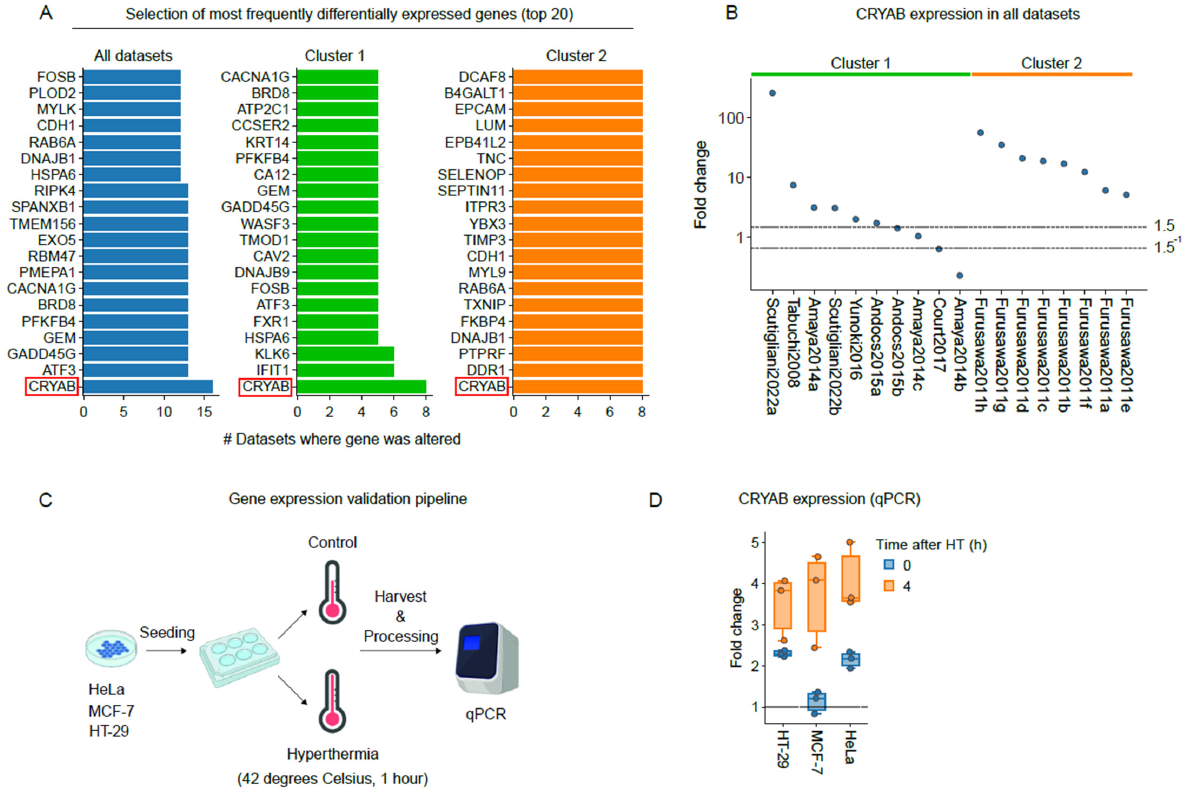
Figure 5. CRYAB expression is enhanced in response to hyperthermia. ( A ) Top 20 most frequently differentially expressed genes in all datasets, and separately in cluster 1 and 2. ( B ) Fold change in CRYAB expression in all datasets. The gray lines depict fold changes that were used as inclusion criteria for differentially expressed in the meta-analysis (i.e., 1.5 − 1 ≥ fold change ≥ 1.5). ( C ) Schematic representation of the pipeline that was used to quantify CRYAB expression using quantitative polymerase chain reaction (qPCR). ( D ) Fold change in CRYAB expression at several time points after hyperthermia (HT) in three cancer cell lines, based on three independent experiments. The horizontal line depicts a fold change of